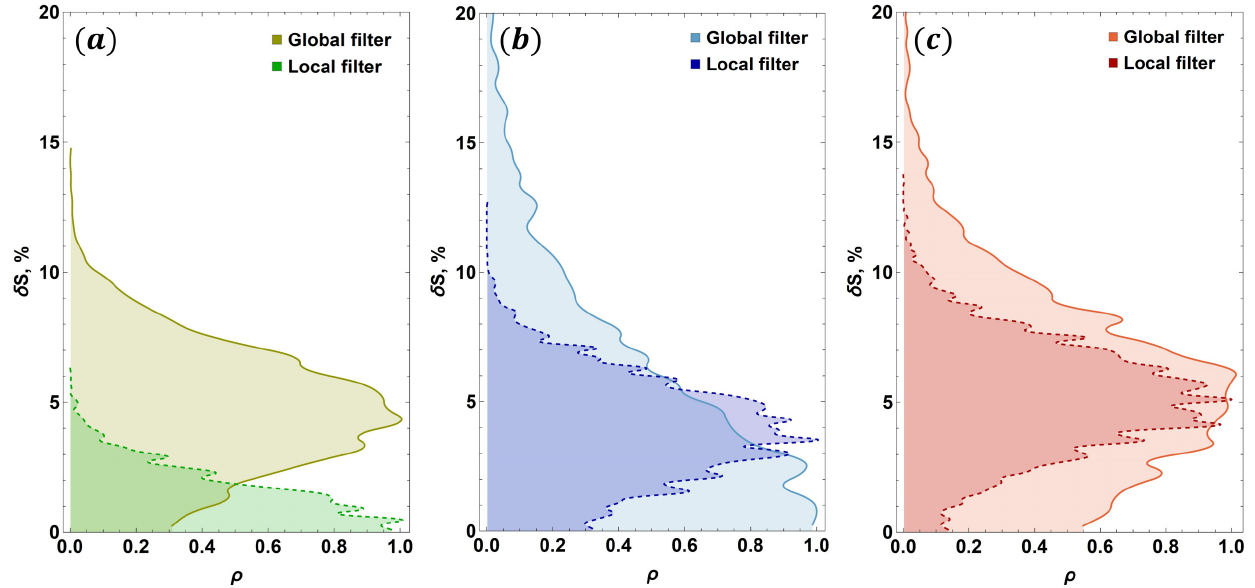
Figure 25. Static reference body: smooth normalized δ S histograms for neutron flux transmission along the ( a ) smaller axis, ( b ) larger axis and ( c ) larger axis with an extra 1 cm distance between the scintillator and the